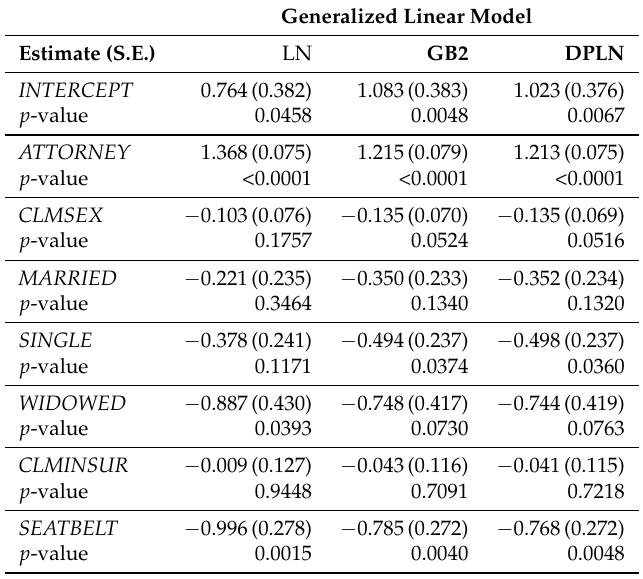
Table 6. Parameter estimates, standard errors (S.E.) and p -values of the t -test for automobile bodily injury claims dataset under LN, GB2 and DPLN generalized linear